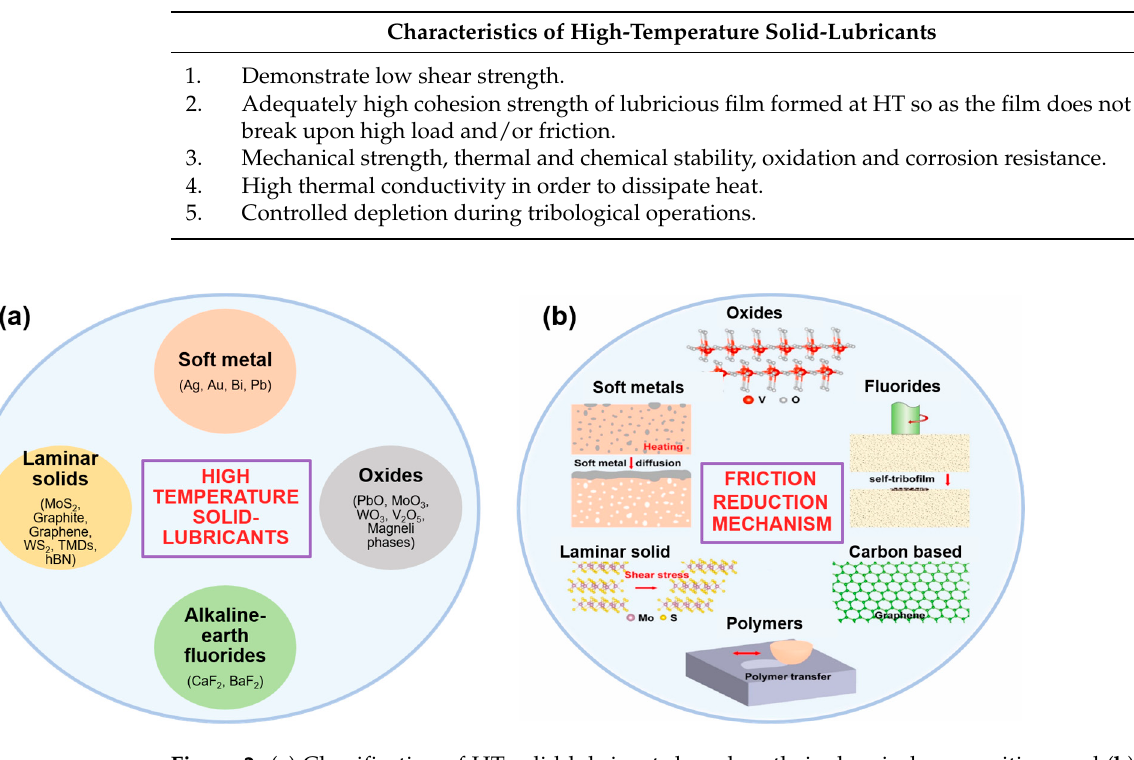
Figure 2. ( a ) Classification of HT solid-lubricants based on their chemical composition; and ( b ) a scheme showing the mechanism of their friction reduction.